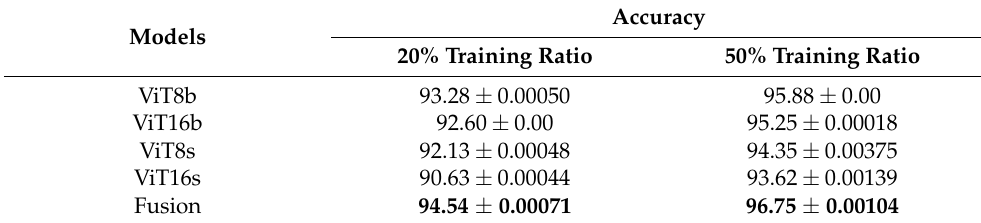
Table 4. Comparison with different ViT features on the AID data set.